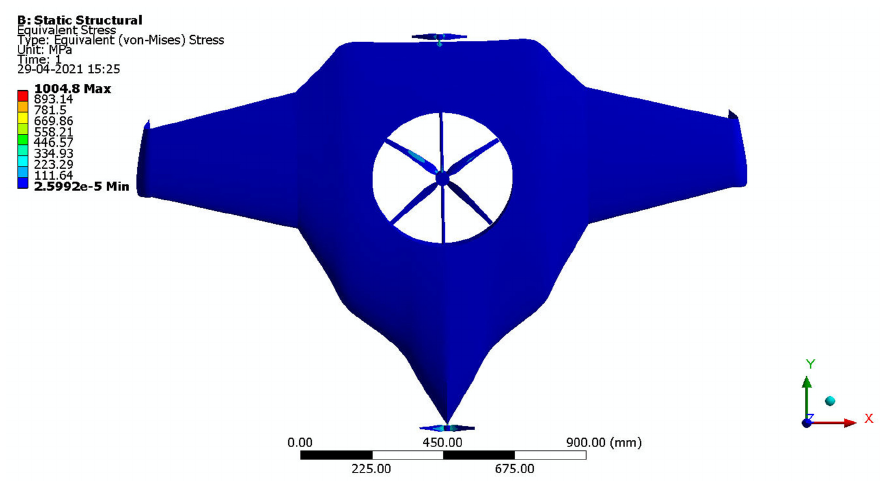
Figure 11. Equivalent stress.